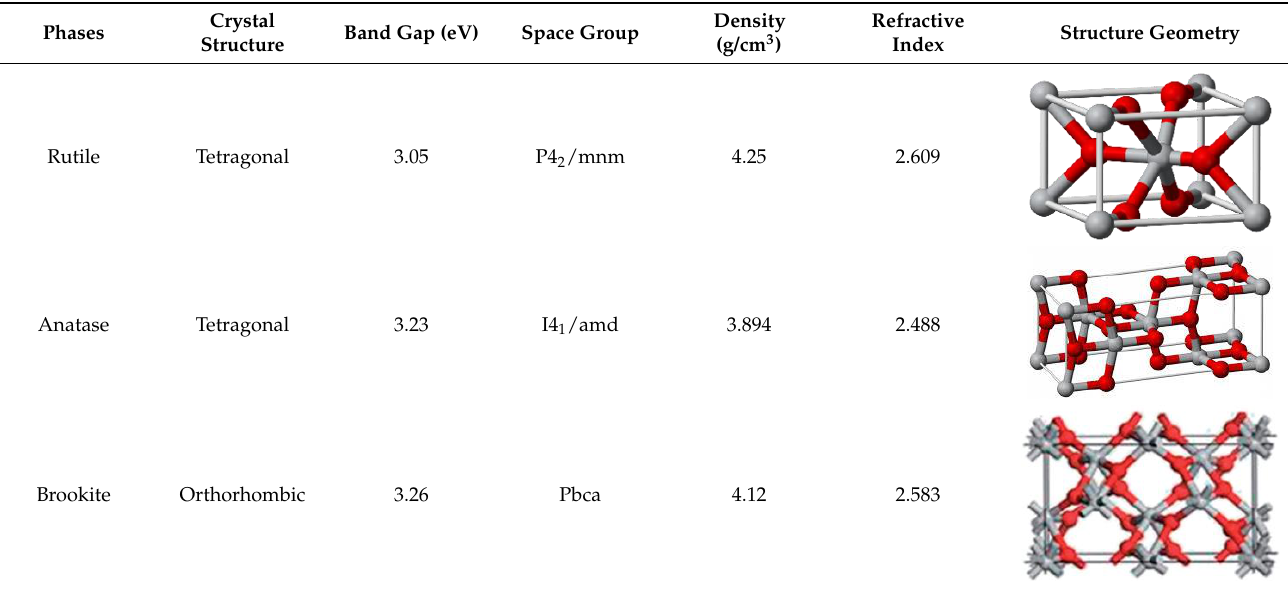
Table 4. Properties of rutile, anatase, and brookite of TiO 2 [83].